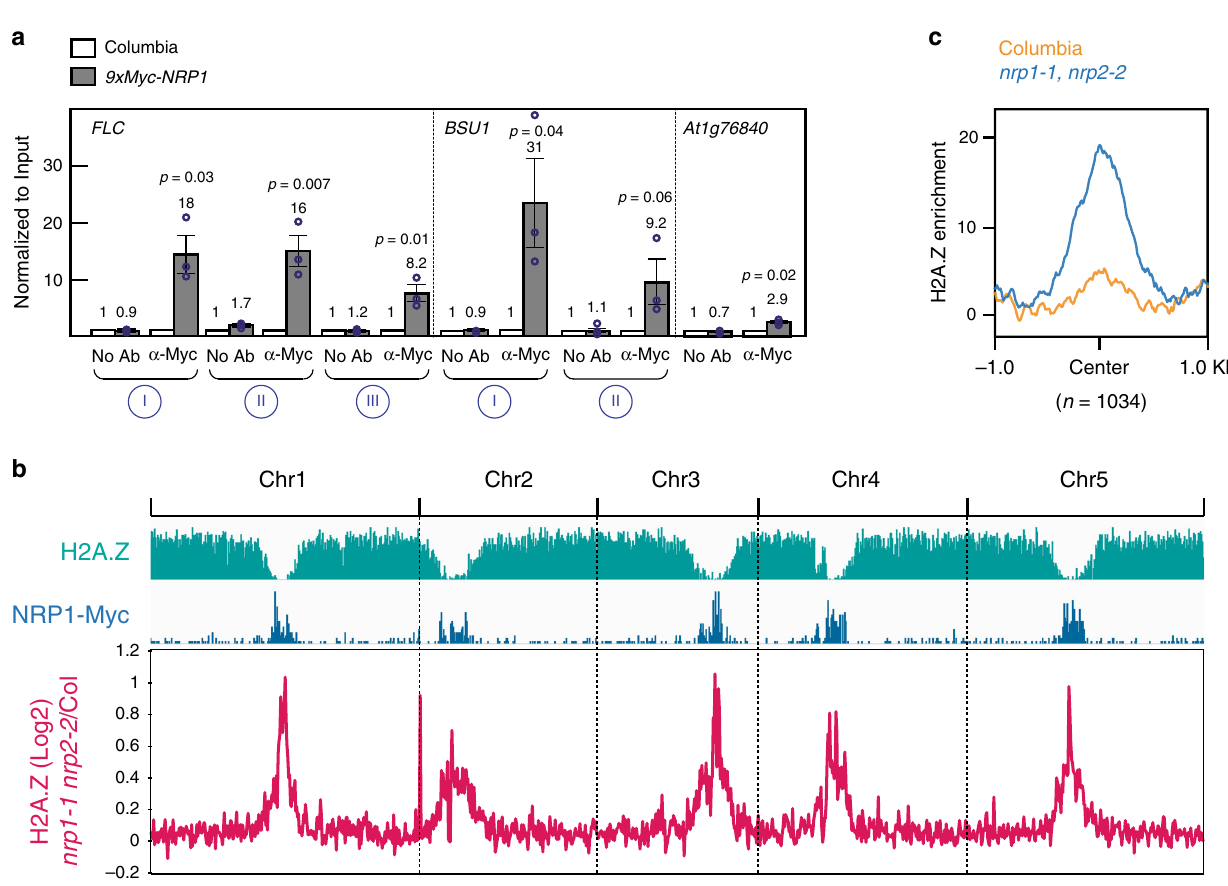
Fig. 4 Genome-wide localization of NRP1. a Quanti fi cation of 9xMyc-NRP1 binding to FLC and BSU1 occupancy levels in Columbia (WT) and nrp1-1 nrp2-2 double mutant. Error bars represent standard error from three biological replicates. Two-tailed, paired Student ’ s t test was used to determine p -value. At1g76840 , which has almost no reads in ChIP-Seq analysis, is shown as a control. b Genome-wide distribution of H2A.Z in wild-type (turquoise) and NRP1-9xMyc in wild-type (blue). In both cases, peaks were de fi ned using Narrow Peaks. The magenta line represents differential H2A.Z occupancy between nrp1-1 nrp2-2 and Columbia. c H2A.Z occupancy levels in Columbia (WT) and nrp1-1 nrp2-2 double mutant background plotted over